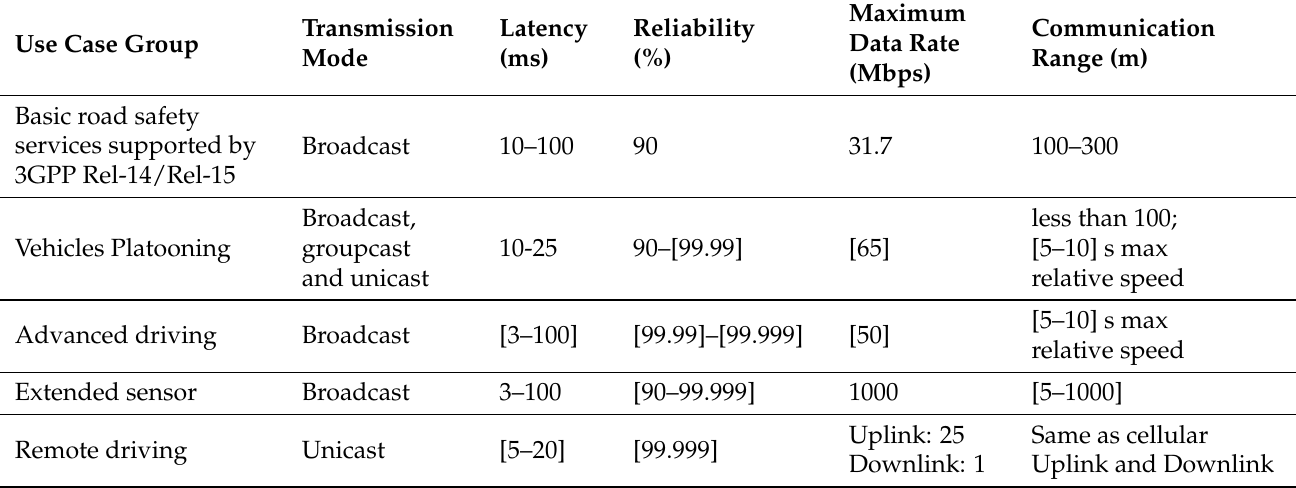
Table 1. Performance Requirements for the Basic Road Safety and Advanced V2X Services